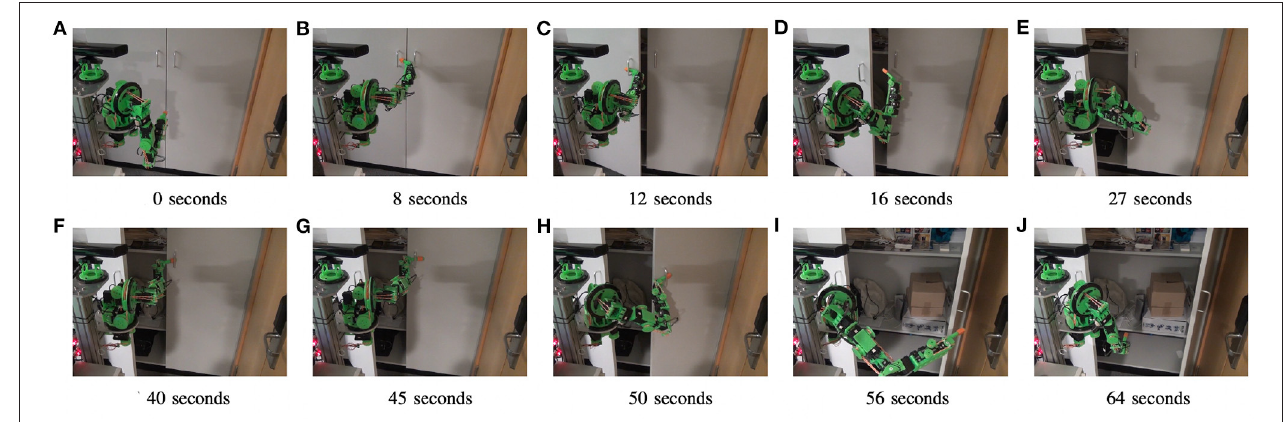
FIGURE 9 | Being able to vary the level of passive compliance in real-time is useful during teleoperation with physical interactions. The GummiArm v1.0 was here teleoperated with a 3DConnexion SpaceNavigator 6 DOF input device. The task was to open both cabinet doors using only a rigid finger end-effector. The task was achieved in 64 s, helped by varying the stiffness of the arm in real-time. For example setting the arm joints loose while having the finger locked in the cabinet door handle. A high stiffness was for example used when pushing with the finger on the first door to open it fully. See full video here: https://youtu.be/QEHxqkwRZZE. (A)